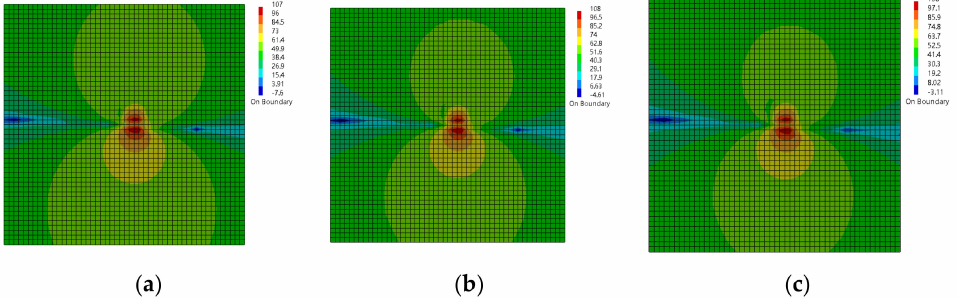
Figure 9. Acoustic radiation field corresponding to different damping thickness (50 Hz): ( a ) 5 mm; ( b ) 10 mm; ( c ) 20 mm.